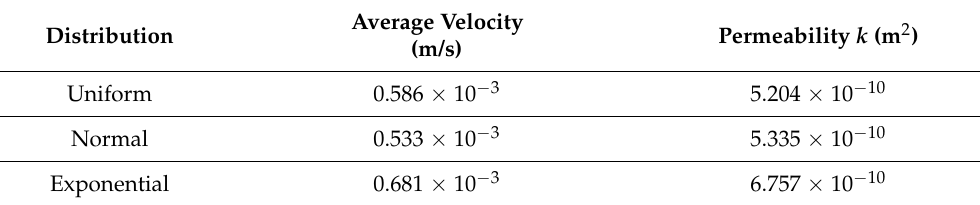
Table 5. Permeability and average velocity of different